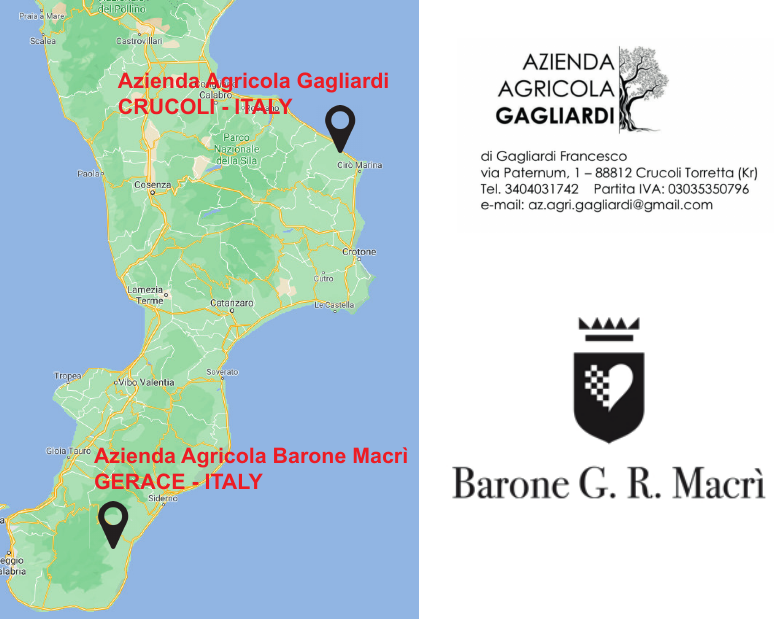
Figure 13. The experimental site geographic